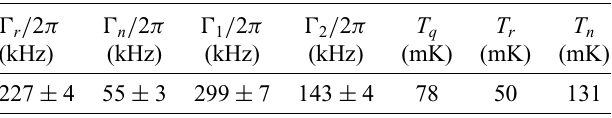
TABLE I. Summary of the system parameters including differ- ent qubit decay rates and temperatures of the qubit, waveguide and the hot